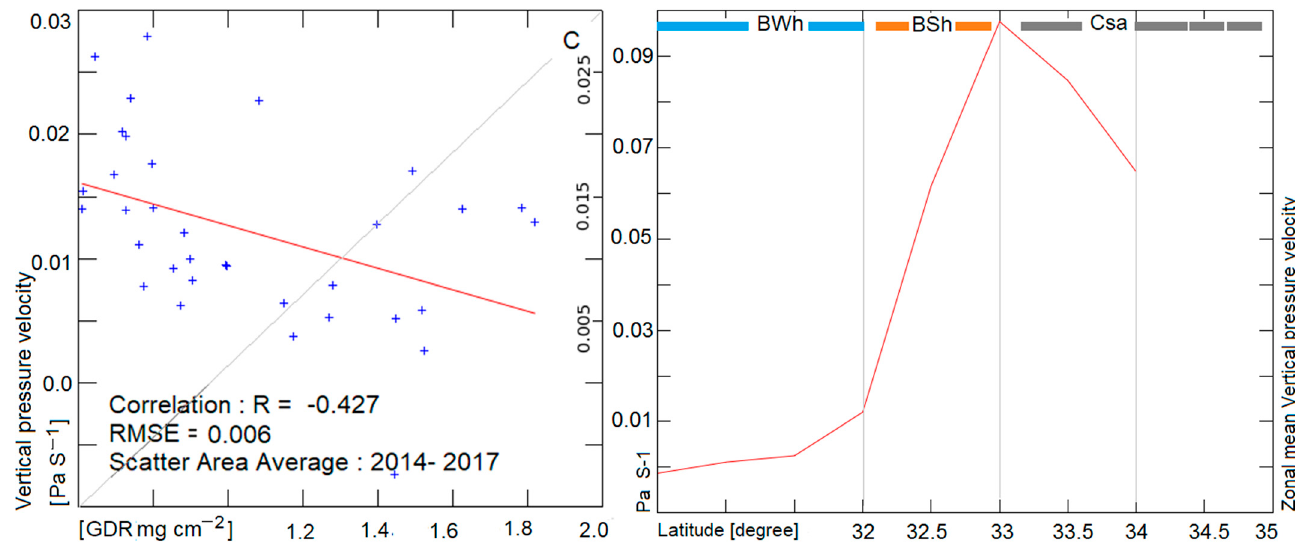
Figure 14. Correlation between vertical pressure velocity and eolian deposition rate. Left : Correlation of vertical pressure velocity (Pa s − 1 ) versus ground deposition rate (GDR) and Root Mean Square Error (RMSE) during the period 2014–2017. Right : Zonal means of vertical pressure velocity plots versus climate zones, which are represented in narrow bands at the top, wherein blue, orange, and gray denote BWh, BSh, and Csa, respectively).